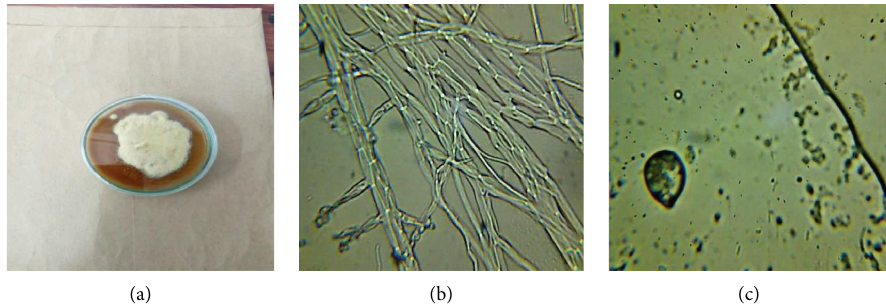
Figure 2: Macroscopic and microscopic characteristics of Lagenidium ajelloi . (a) Irregular colony; (b) hyphae; (c) zoospore cysts.